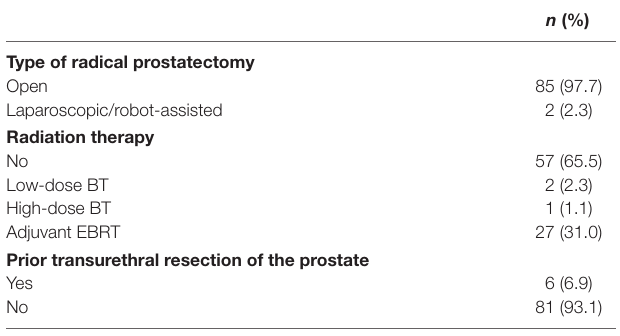
TaBle 1 | Patients treated for vesicourethral